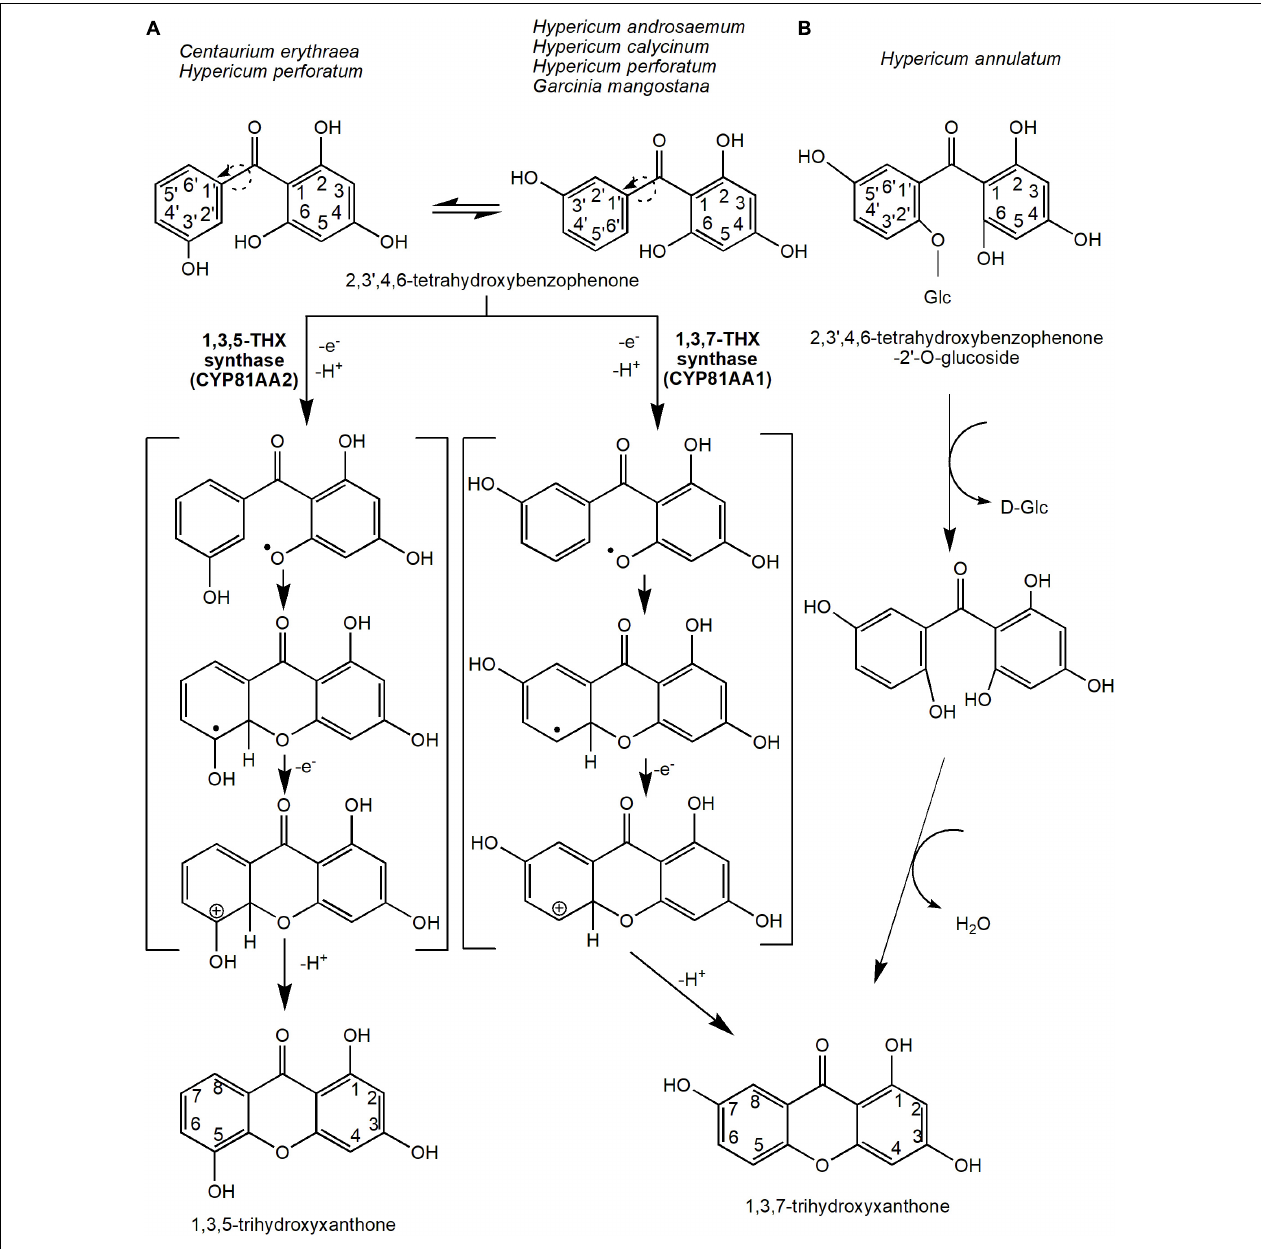
FIGURE 3 | The reaction mechanisms for the two main precursors of xanthones, 1,3,5-trihydroxyxanthone and 1,3,7-trihydroxyxanthone. This oxidative phenol coupling reaction is present in several plant species including C. erythraea , H. androsaemum , H. calycinum, H. perforatum, and G. mangostana . (A) In addition, 1,3,7-trihydroxyxanthone can be formed through the deglycosidation process of 2,3 (cid:48) ,4,6-tetrahydroxybenzophenone-2 (cid:48) -O-glucoside in H. annulatum . (B) Dotted arrows indicate hypothetical/proposed pathways while protein activities detected at the molecular level are in bold (refer to Table 1 ). CYP, cytochrome P450; THX,